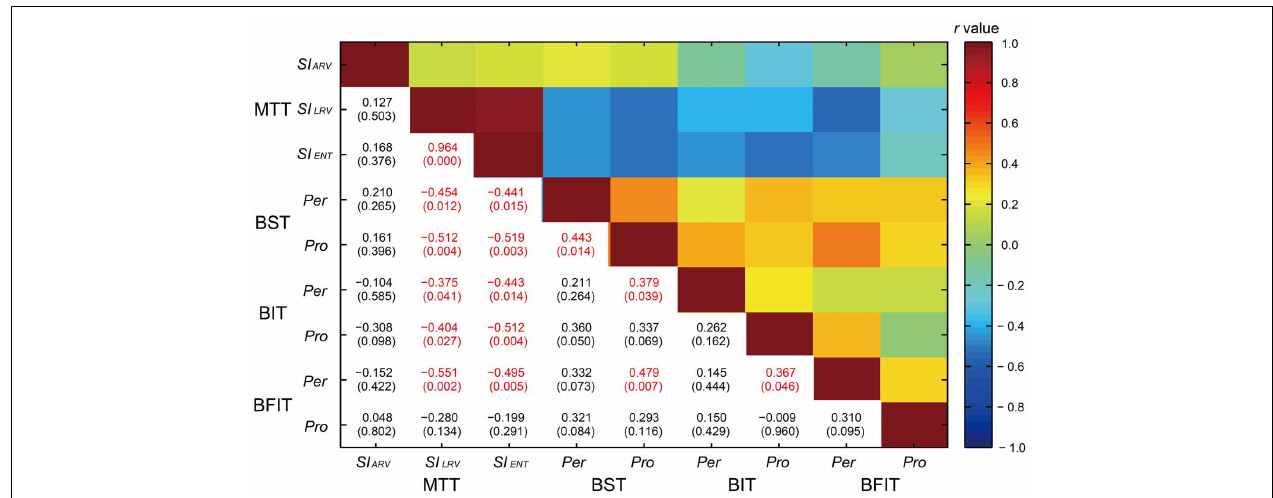
FIGURE 12 | A correlation matrix across the 9 behavioral variables in the Harvard Beat Assessment Test (H-BAT) using Pearson’s correlation coefficients ( r ). The values in parenthesis indicate p -values (red text, significant at p < 0 . 05). MTT, music tapping test; BST, beat saliency test; BIT, beat interval test; BFIT, beat finding and